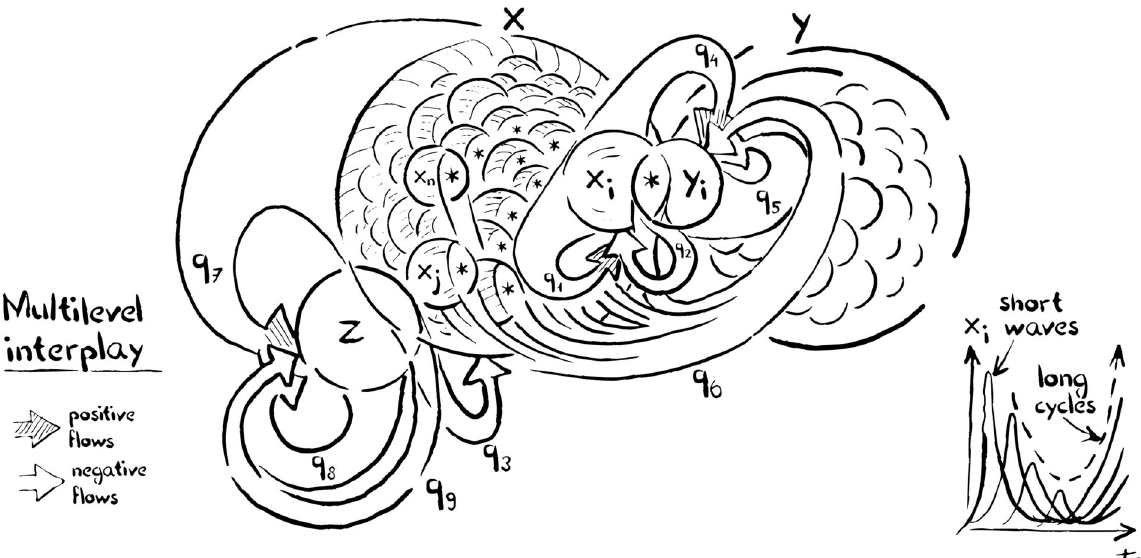
Fig. 4 Multi-level interplay. In human culture, small sub-categories often cluster into larger, overarching categories. This hierarchy is taken into account in multi-level models that predict short growth waves as well as longer cycles of growth and reform. x represents an overarching category (science at large). x 1 , x 2 , x 3 , … x n are the subcategories of x (the various scienti fi c fi elds of study). y 1 , y 2 , y 3 , … y n are habituation (boredom) against each of the subcategories separately. z is habituation against the overarching category x in its entirety. The equations are given in the section “ Equations ” as well as in Baciu (2021e). Source: Dan C. Baciu. License: